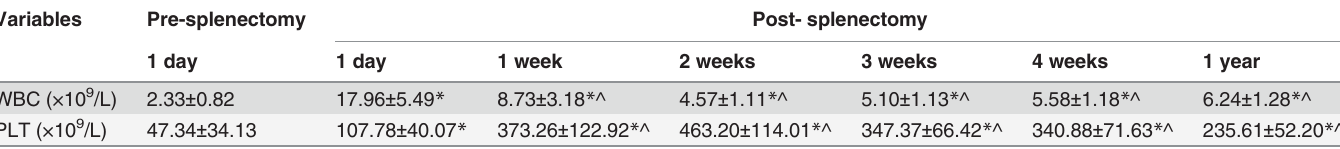
Table 3. Comparisons of WBC and PLT counts before and after splenectomy (mean ± SD). Variables